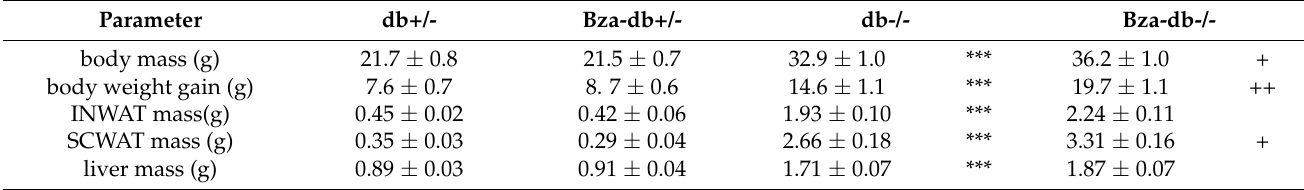
Table 2. Effect of Bza supplementation on adipose tissue and liver wet mass in 11-week old db+/- and db-/- mice. Parameter db+/- body mass (g) body weight gain (g) 7.6 ± 0.7 INWAT mass(g) SCWAT mass (g) liver mass (g) As in Figure 1, results are means ± SEM of 14 mice for Bza-db+/-, and 18 for Bza-db-/- treated groups, (7/7 and 9/9 males/females, respectively), and 21–28 mice in their corresponding control groups db+/- and db-/-. Difference between db+/- and db-/- genotypes significant at: *** p < 0.001; difference between Bza-db-/- and db-/- significant at: + p < 0.05; ++ p < 0.01. No significant difference was found between db+/- and Bza-db+/- by two-way ANOVA. INWAT, intra-abdominal white adipose tissues; SCWAT, subcutaneous white adipose